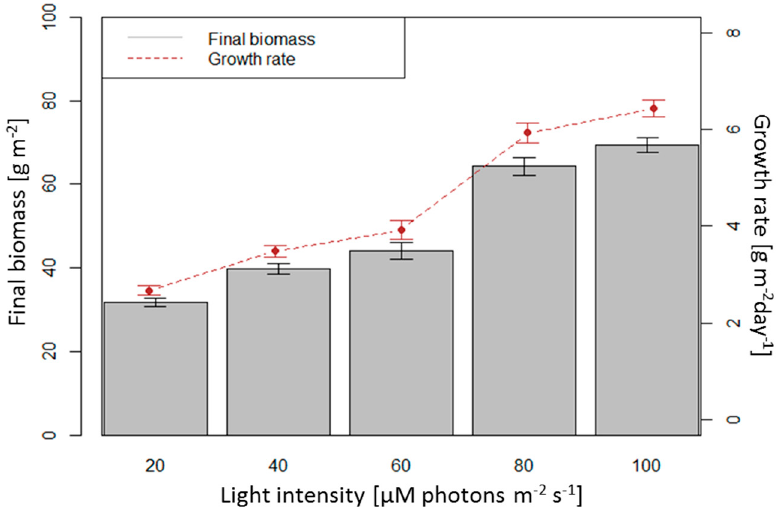
Figure 2. Final biomass and biomass growth rate (average of biomass increase per day over ten days) of Haematococcus pluvialis under different light intensities (in the range of 20–100 µmol photons m − 2 ·s − 1 ).